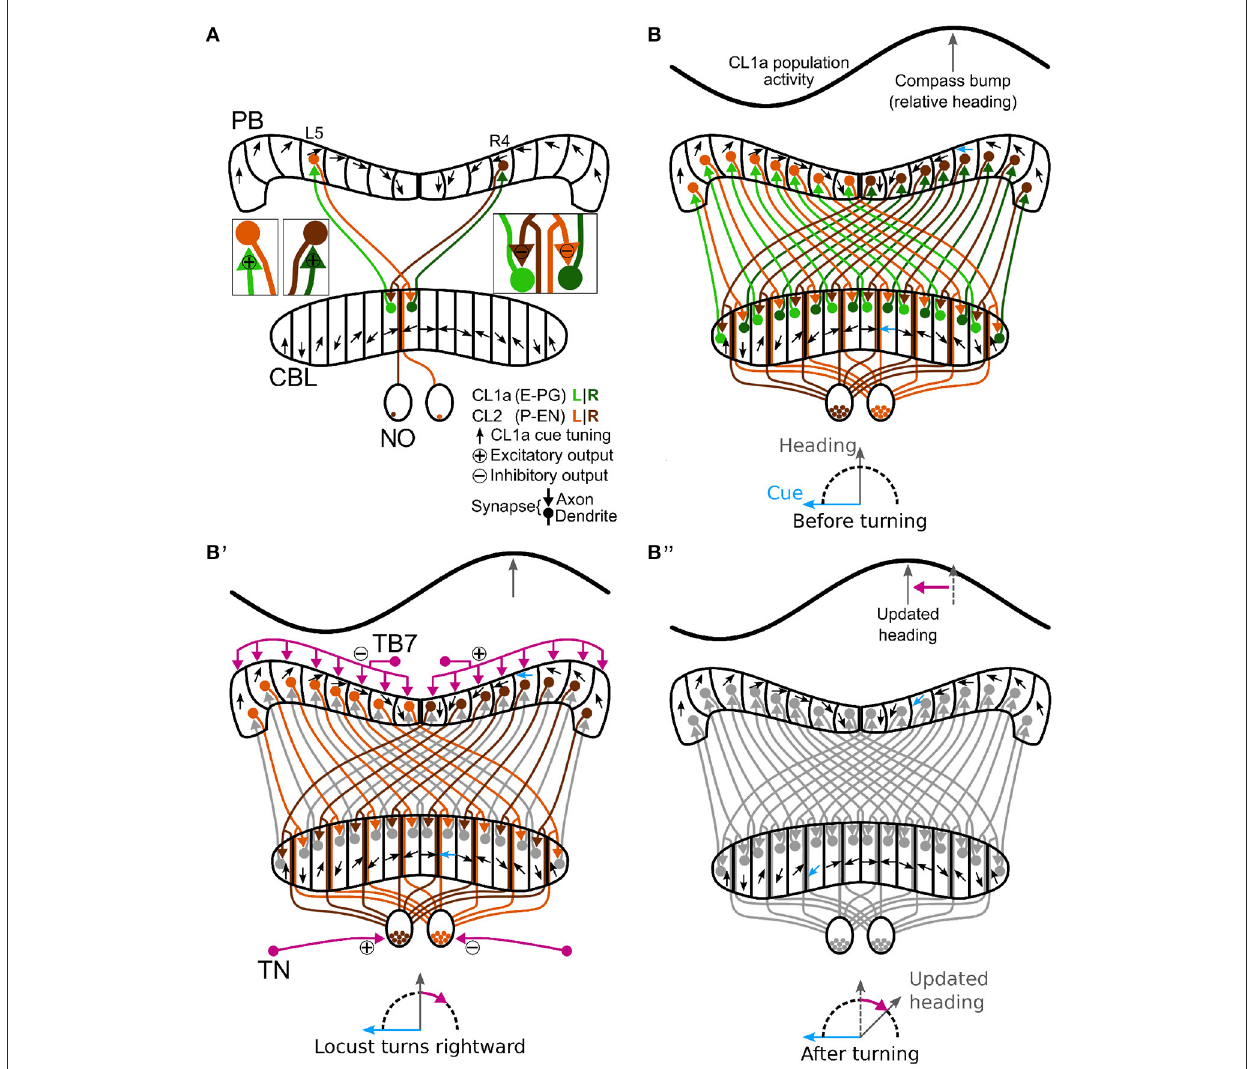
FIGURE5 Schematic wiring diagram of CL1a and CL2 columnar neurons in the central complex and hypothetical shift mechanism of the internal heading signal in the PB. (A) Schematic wiring diagram of the CX with a subset of the involved neuron types: CL1a and CL2 neurons are connected to one another in the protocerebral bridge (PB) and lower division of the central body (CBL), while CL2 neurons also have postsynaptic arborizations in the noduli (NO). CL1a neurons are topographically tuned to solar azimuth along the PB (black arrows). (B, B”) Hypothetical shift mechanism of the internal heading signal in the PB. (B) Full population of CL1a and CL2 neurons and initial activity state in the network: With an environmental cue (sun) 90 ◦ left of the locust (bottom), the CL1a population activity (top) has a distinct maximum according to the neural tuning (highlighted arrows in PB and CBL). (B’) When the locust turns right, CL2 neurons are excited or inhibited depending on their brain side. Neurons that innervate the left (right) NO are excited (inhibited) by tangential neurons (TN) from the lateral complexes and relay onto CL1a neurons from the left (right) half of the PB. This asymmetric input may analogously be conveyed in the PB by tangential neurons (TB7) from the superior posterior slope. (B”) After turning, the CL1a population activity maximum is shifted so that the neural heading estimate accordingly represents the new heading relative to the